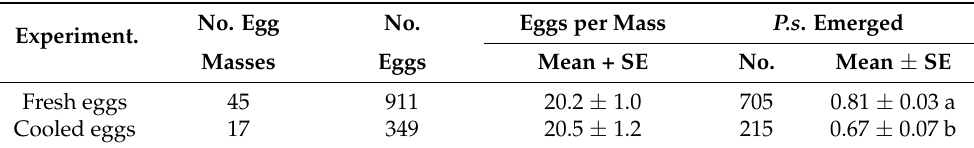
Table 5. Comparison of emergence of P. saccharalis ( P.s. ) from freshly laid eggs and cooled eggs of M. cribraria in laboratory